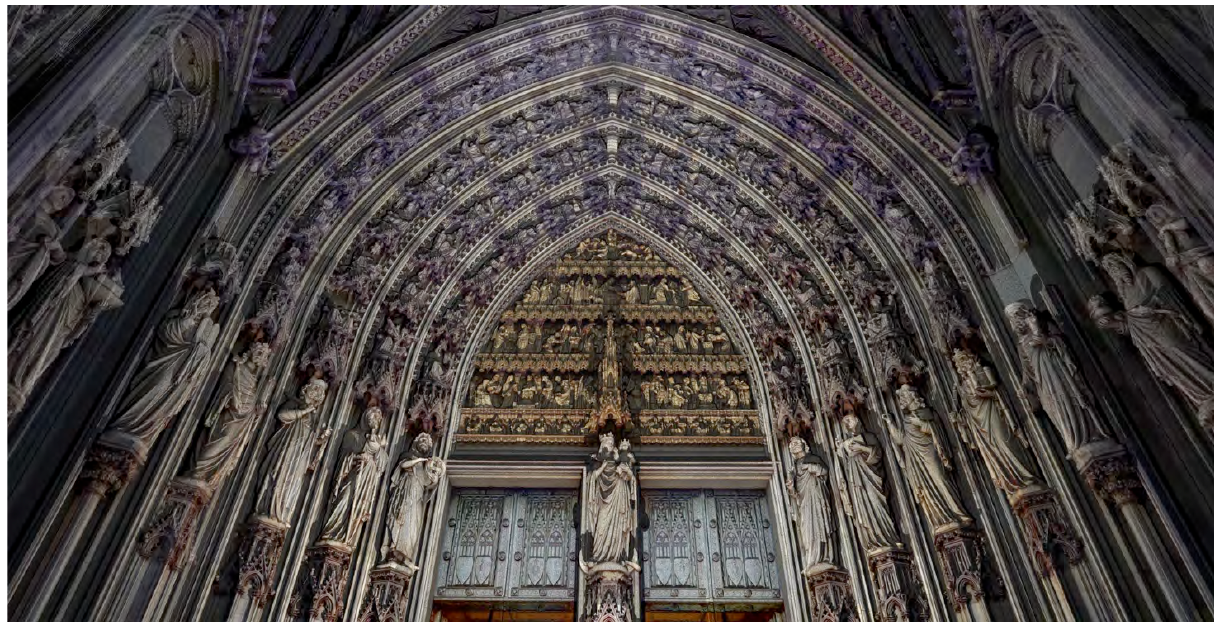
Image 1: Perspective point cloud rendering of main entry into the Cologne Cathedral. A combination of 15 terrestrial laser scans at varying heights with 360-degree HDR